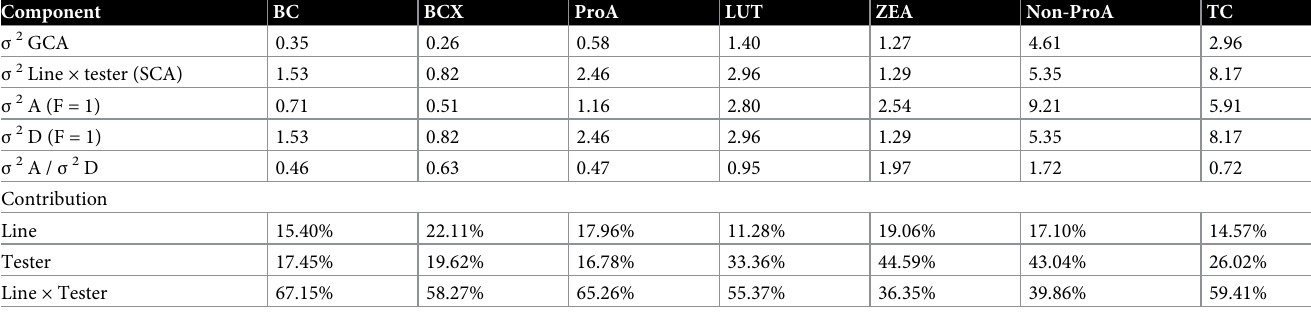
Table 7. Components of genetic variance and percentage contribution in line × tester set. Component BC BCX ProA